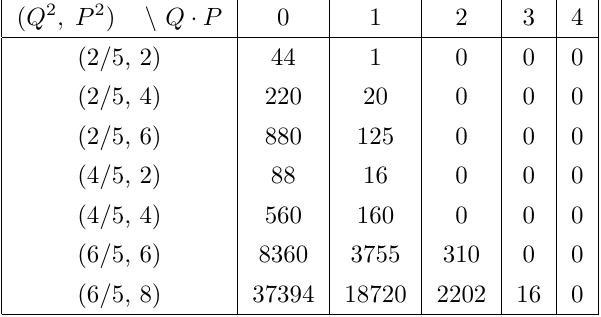
Table 7 . Index of horizon states for the 4 B orbifold of K 3 .